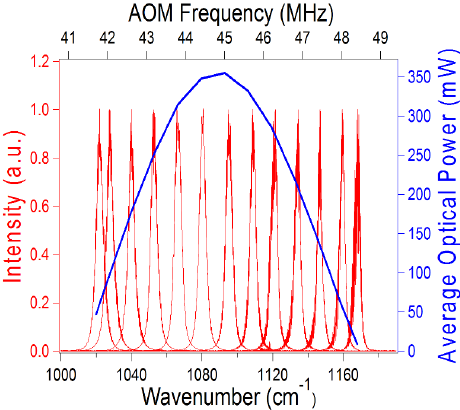
Figure 6. Tuning curve of the QCW AOM-controlled laser.